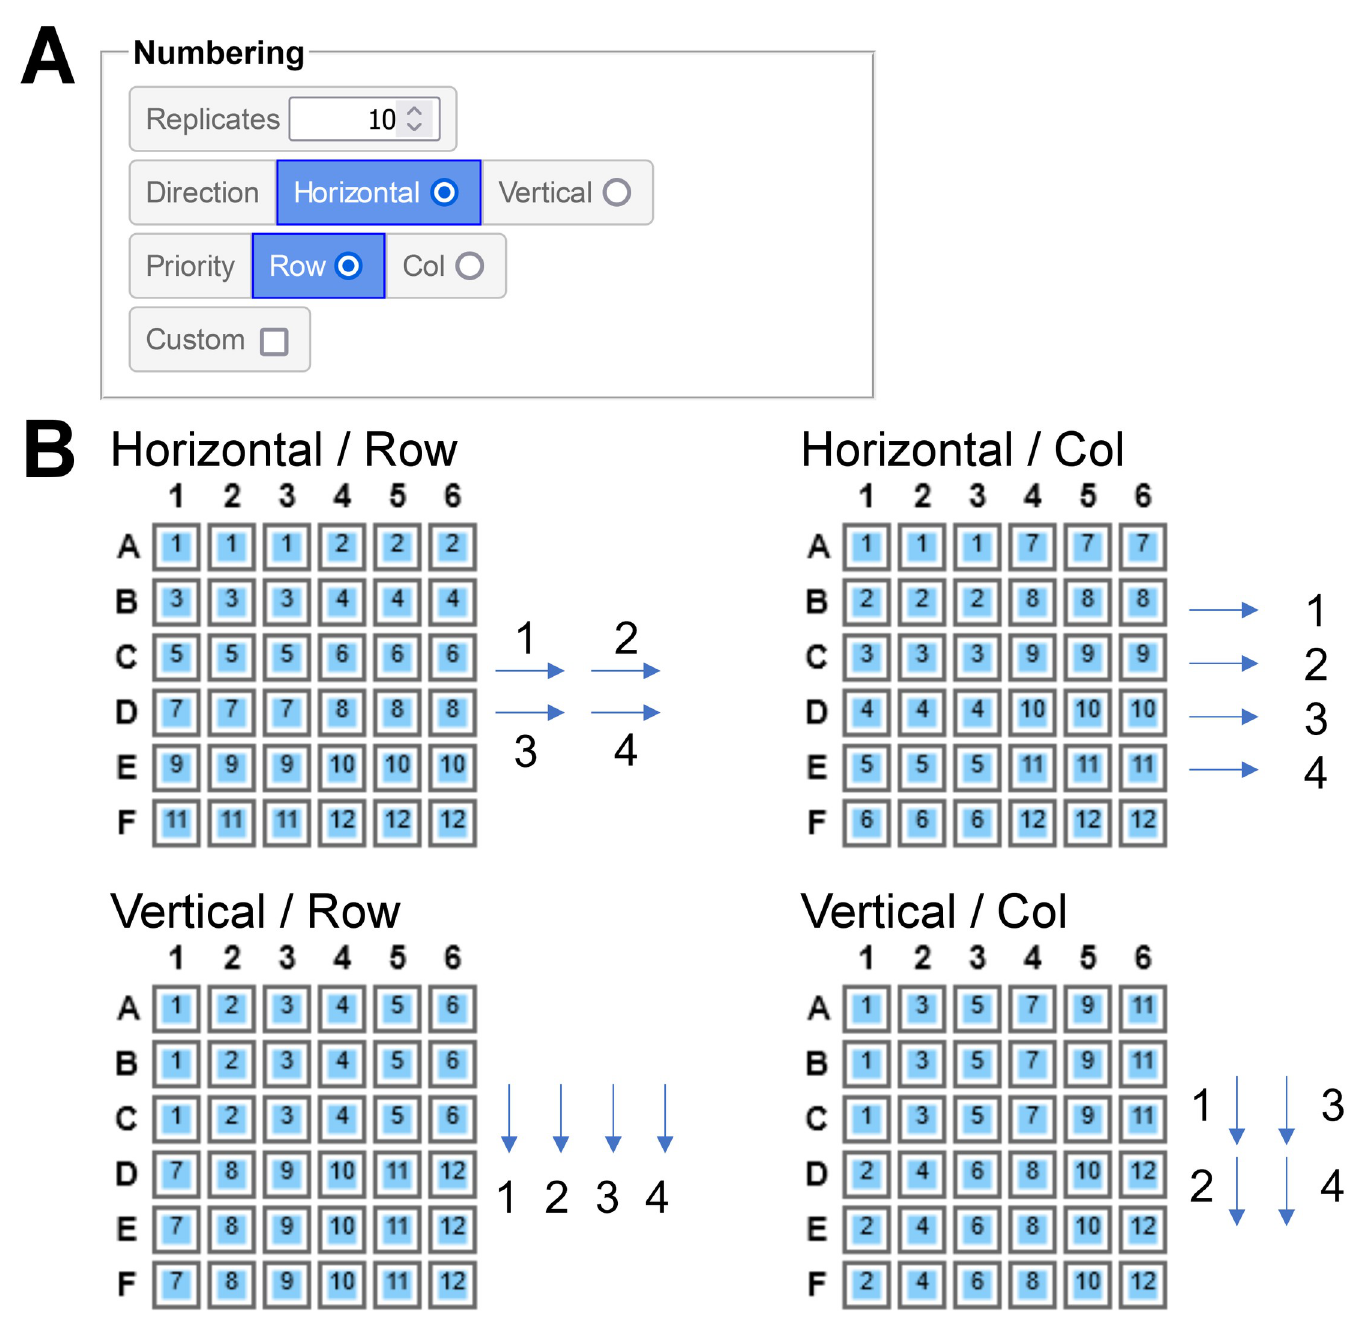
Fig 5. Customization of range numbering. A . Options available for the automatic numbering of Ranges. B . Possible numbering outcomes for each available Direction / Priority configuration, for a range of 3 replicates tagged in a bloc of 6 × 6 wells. A schematic indicating the numbering strategy for the four first range items is shown. Arrows indicate the 3 replicated wells of each range